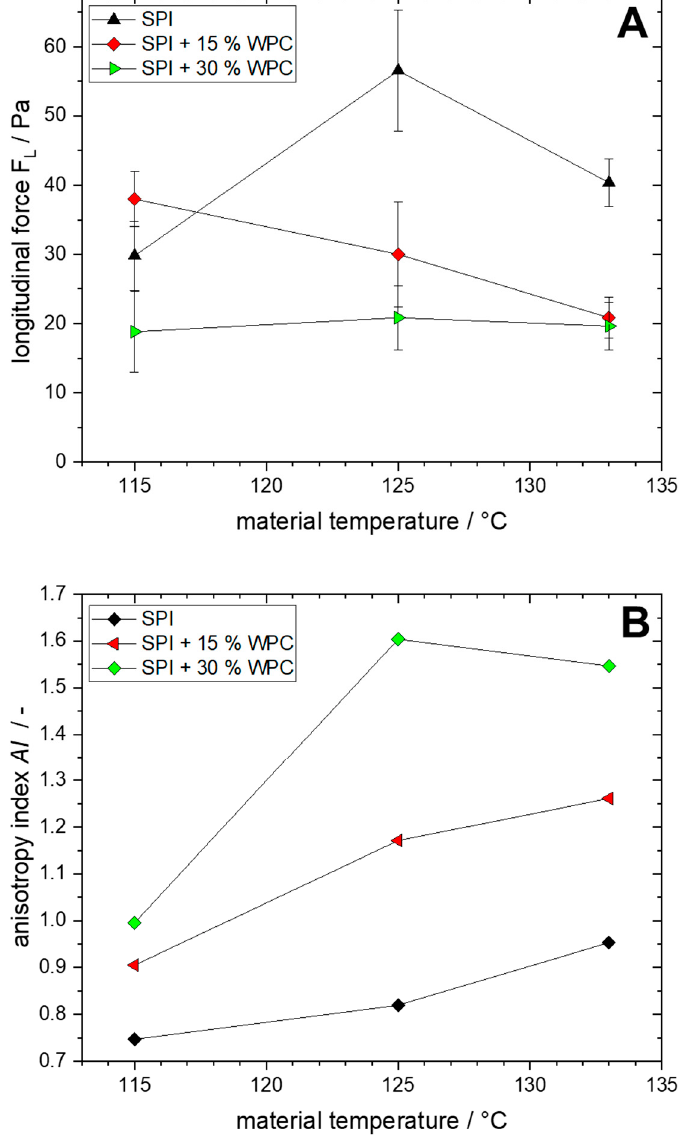
Figure 5. Longitudinal force ( A ) and anisotropy index AI ( B ) as a function of material temperature for different protein blends (0–30% WPC).